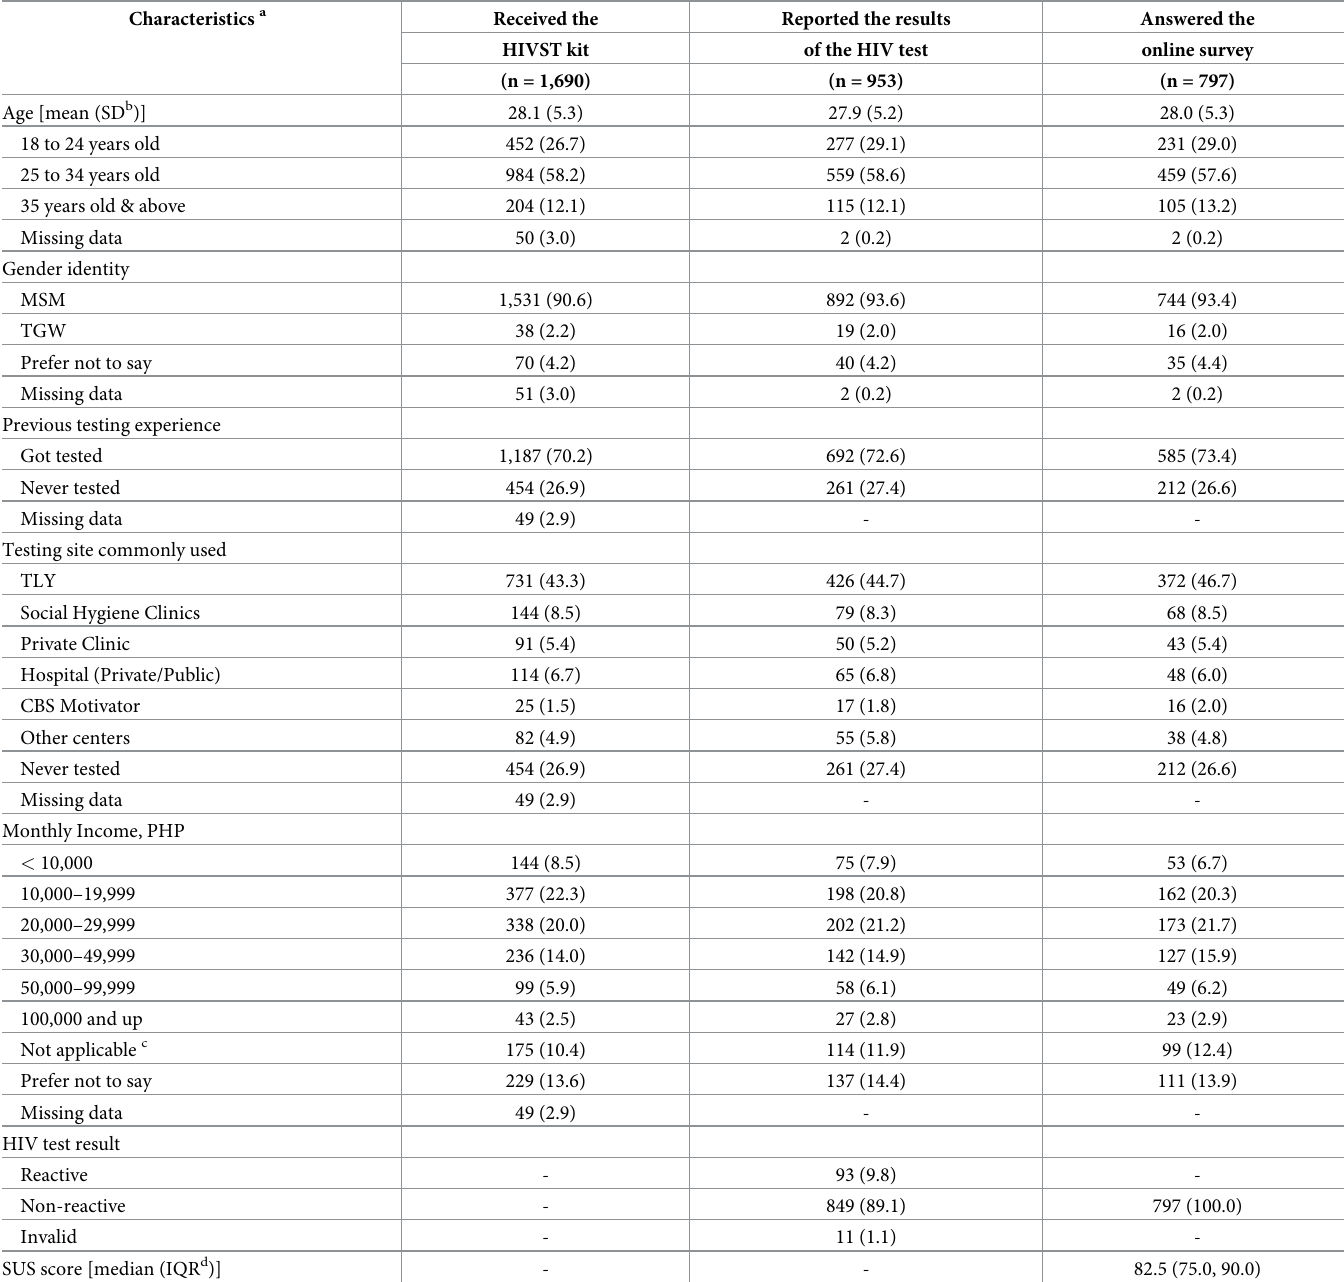
Table 1. Characteristics of the study